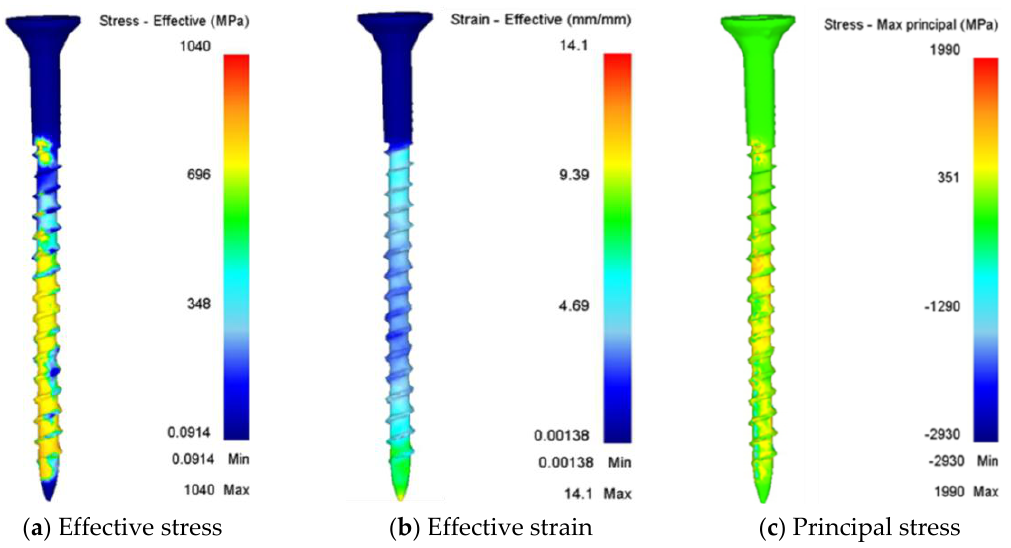
Figure 9. Effective stress, effective strain, and maximum principal stress of a sheet metal tapping screw in 3D.